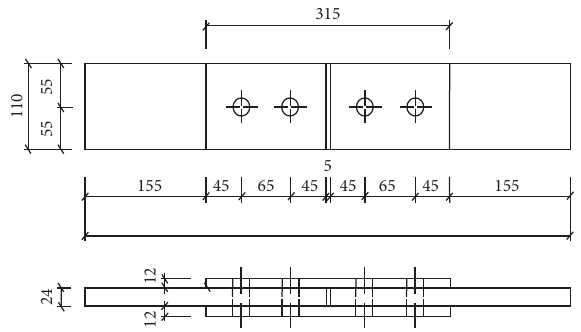
Figure 1: Schematic diagram of specimen details (unit: